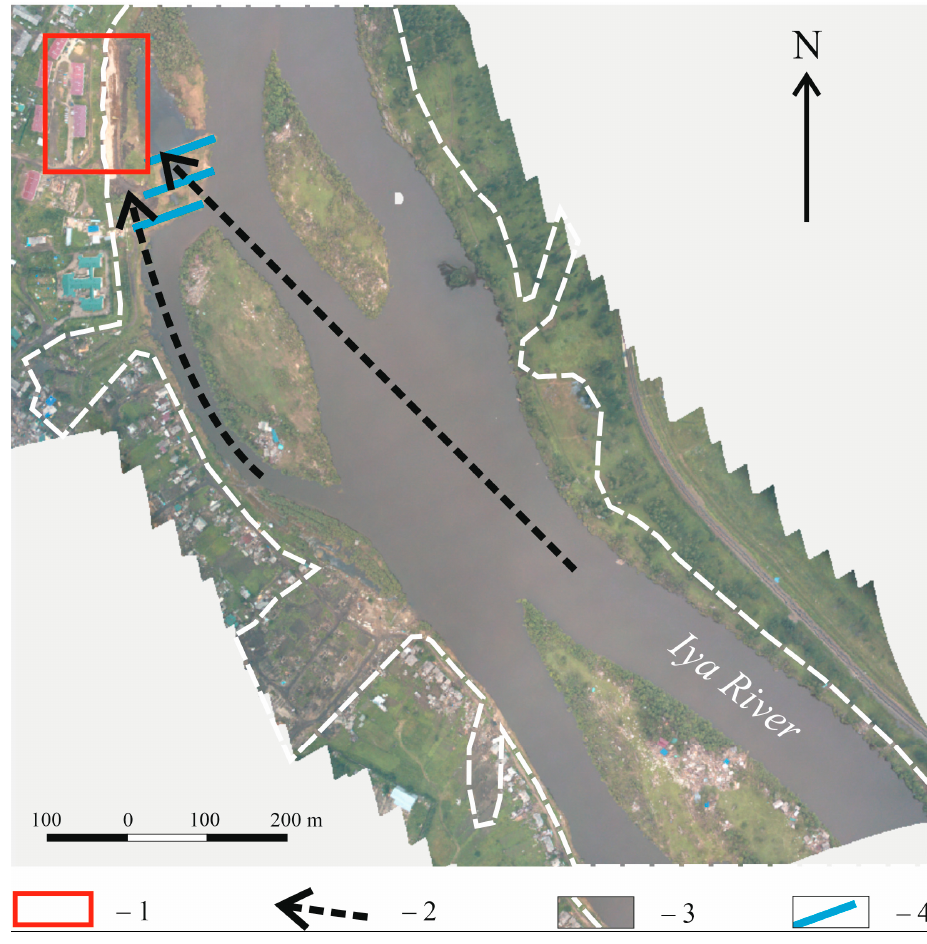
Figure 8. Set of the current of the IyaRiver in the area under study. 1—area under study; 2—set of the current of the IyaRiver; 3—border of the flood zone (7 July 2019); 4—bank protection structure.